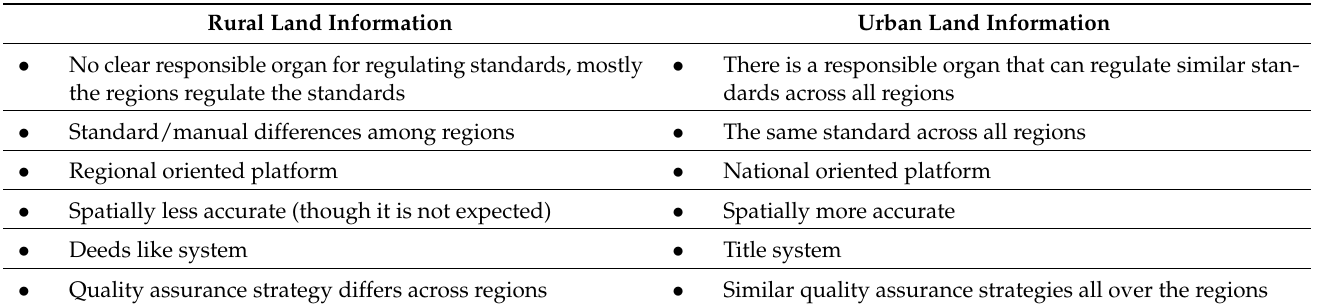
Table 5. The main differences between rural and urban LI (in terms of development and governance of LI). Rural Land